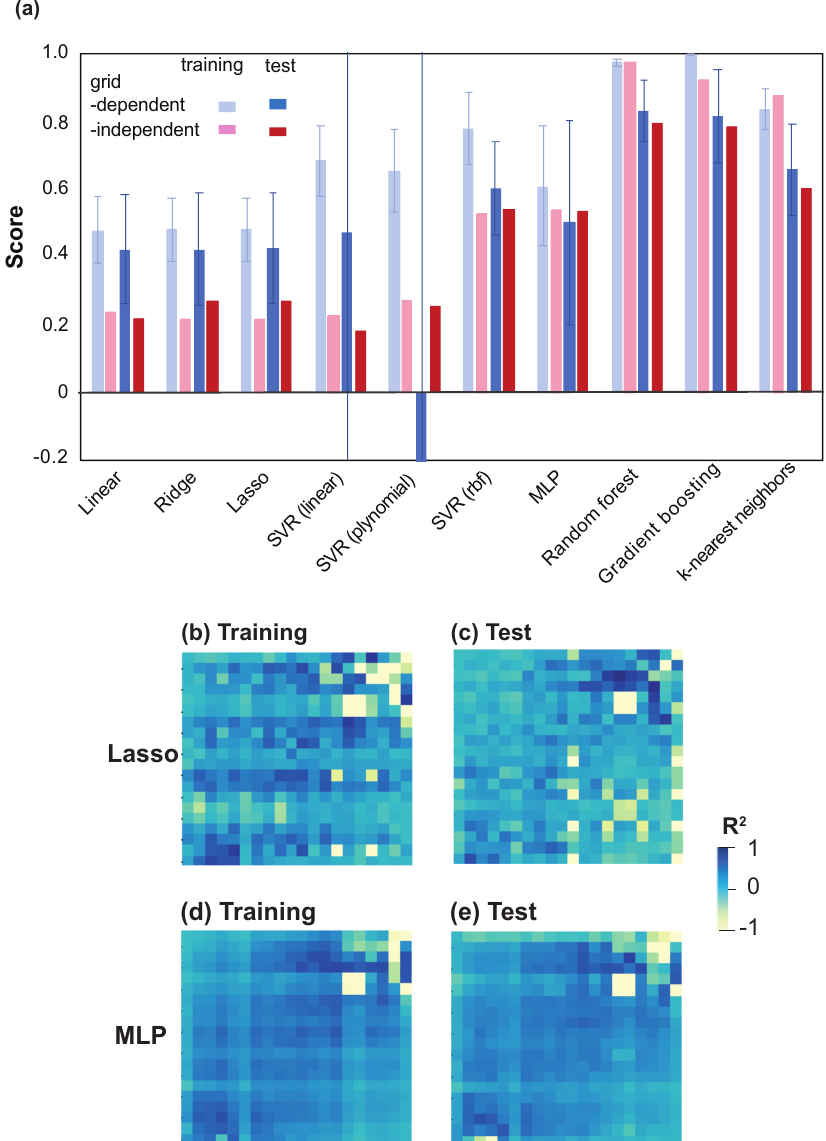
Figure 4. ( a ) Comparison of scores (coefficient of determination: R 2 ) for different methods. ( b ) Train- ing and ( c ) test scores of Lasso model and ( d ) Training and ( e ) test scores of MLP model. The linear, ridge, and Lasso models are based on a linear model. The obtained scores were lower than others (Figure 4a). The accuracy of the grid-dependent models based on their training data is better than that of the grid-independent model. The more diverse relationships between the feature and the target at different locations with different flow patterns in the independent model are more difficult to characterize in the linear